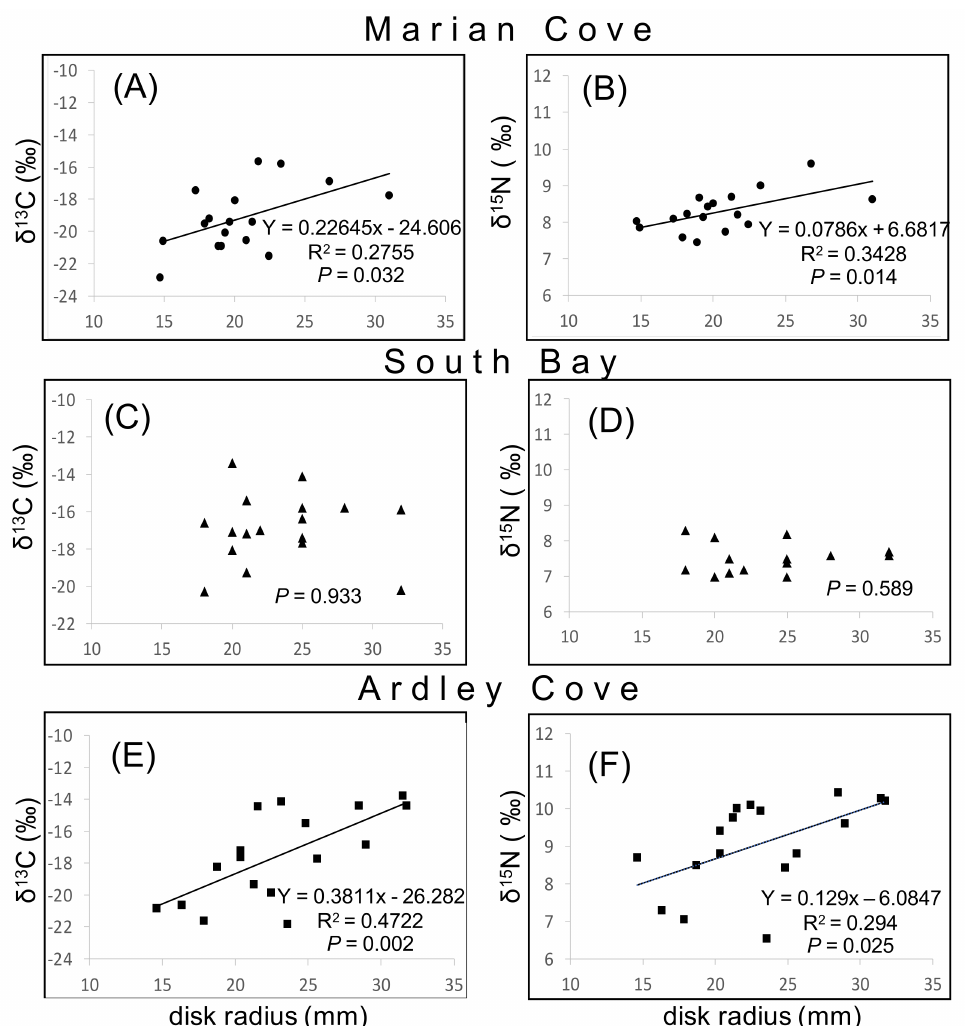
Figure 5. Correlation coefficients between disk radius and δ 13 C and δ 15 N of O. validus from Marian Cove ( A , B ), South Bay ( C , D ), and Ardley Cove ( E , F